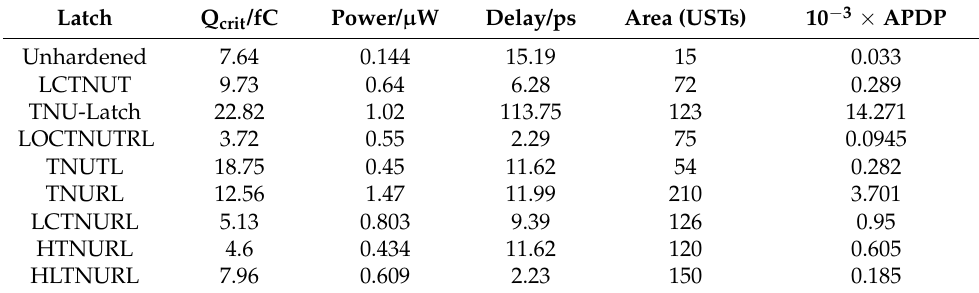
Table 2. Performance and area cost comparisons among the existing TNU latches and proposed HLTNURL